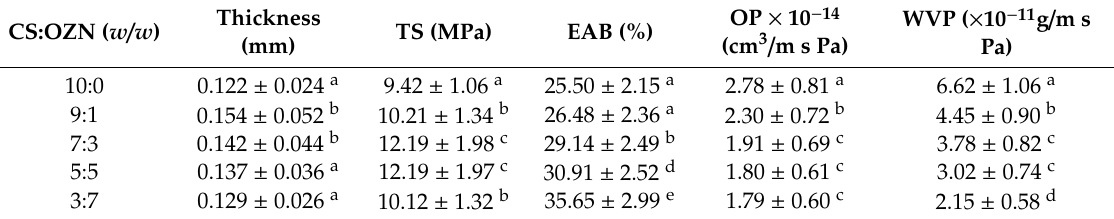
Table 4. Properties of di ff erent CS / OZN composite